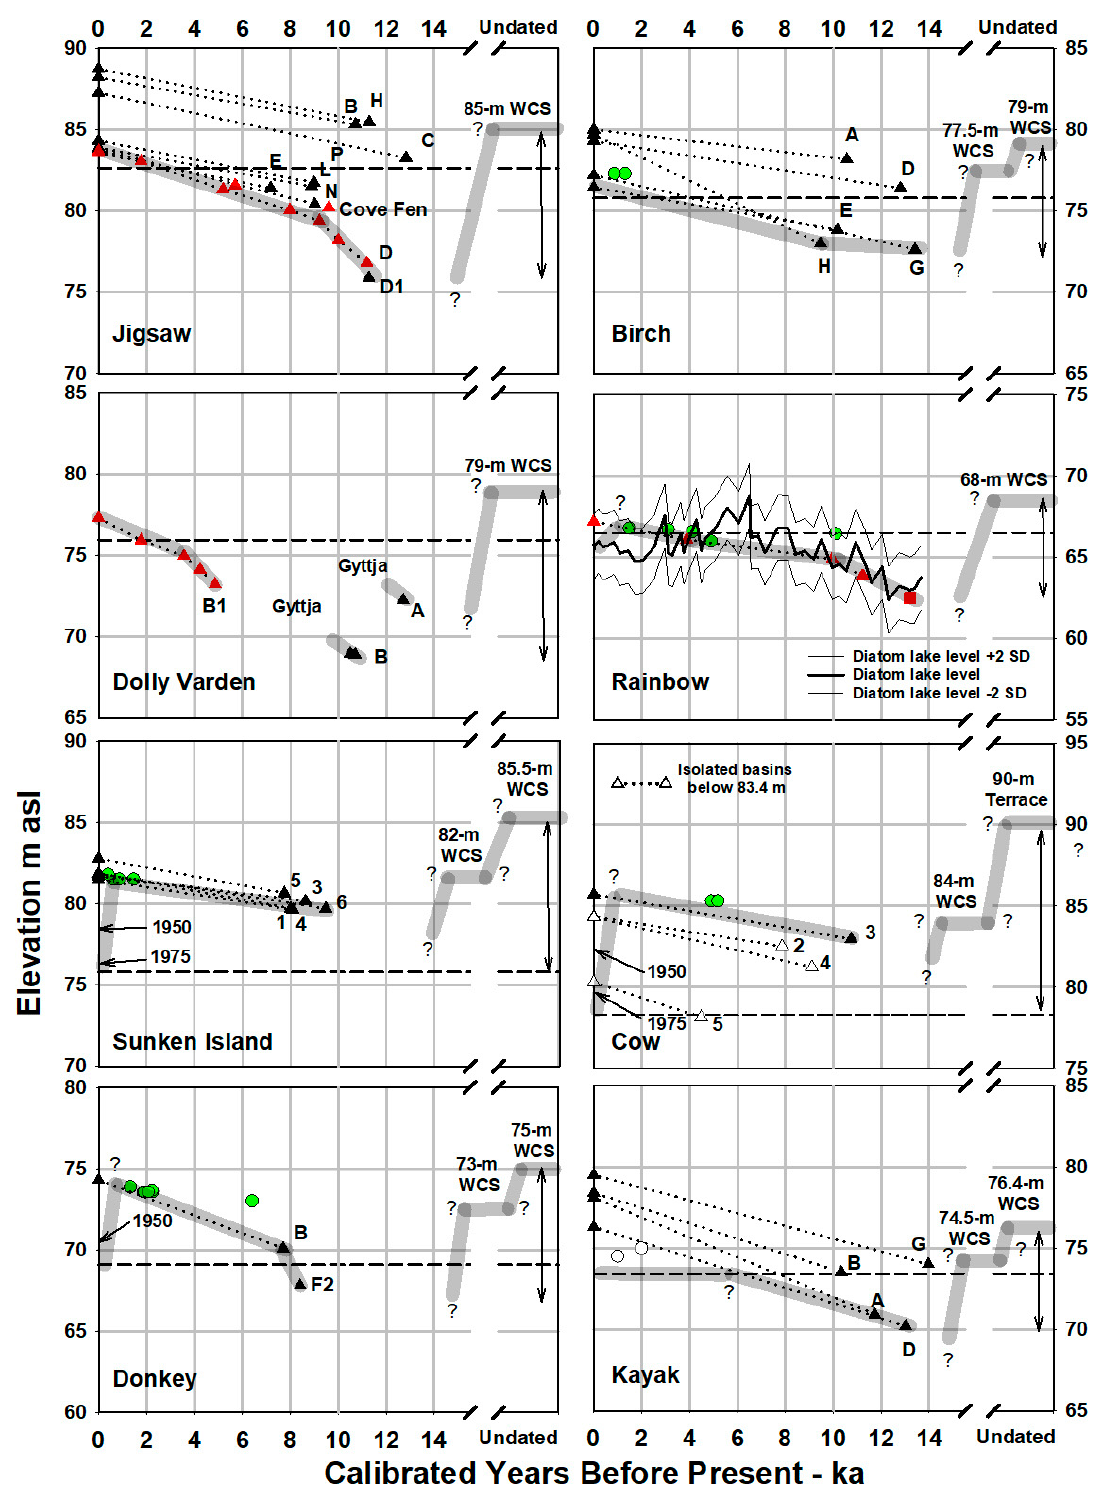
Figure 11. Reconstructed water levels from eight Kenai lakes. Horizontal dashed lines show modern (2008) lake levels. Black triangles show radiocarbon or present (0 ka) dates. Red triangles show multiple radiocarbon dates within a single core. Green circles show ice-shoved rampart (ISR) dates; open circles at Kayak Lake show estimated ISR dates, based on similar ISRs at other lakes. WCSs are wave-cut scarps. Question marks show hypothesized transition dates. Red square (Rainbow Lake) shows a lake sediment core bottom (gyttja) date for the diatom-reconstructed lake level (M. Chipman, pers. comm.